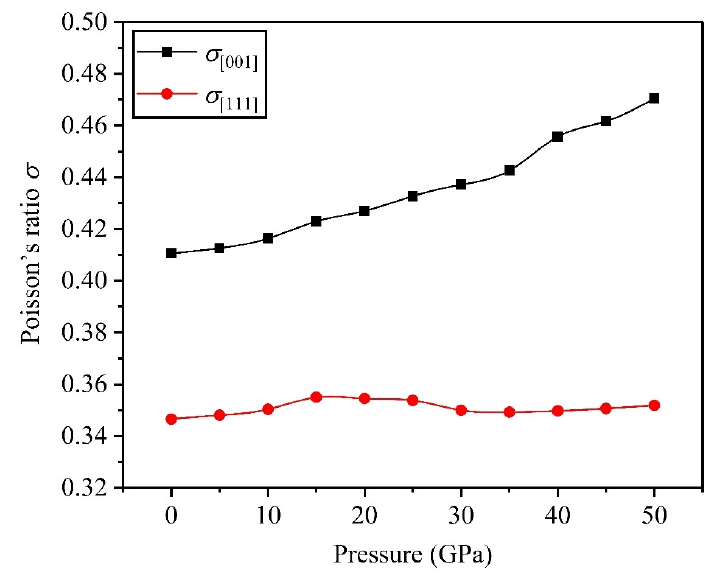
Figure 8. Variation curves of Poisson’s ratios under different pressures for the NiTi SMA.